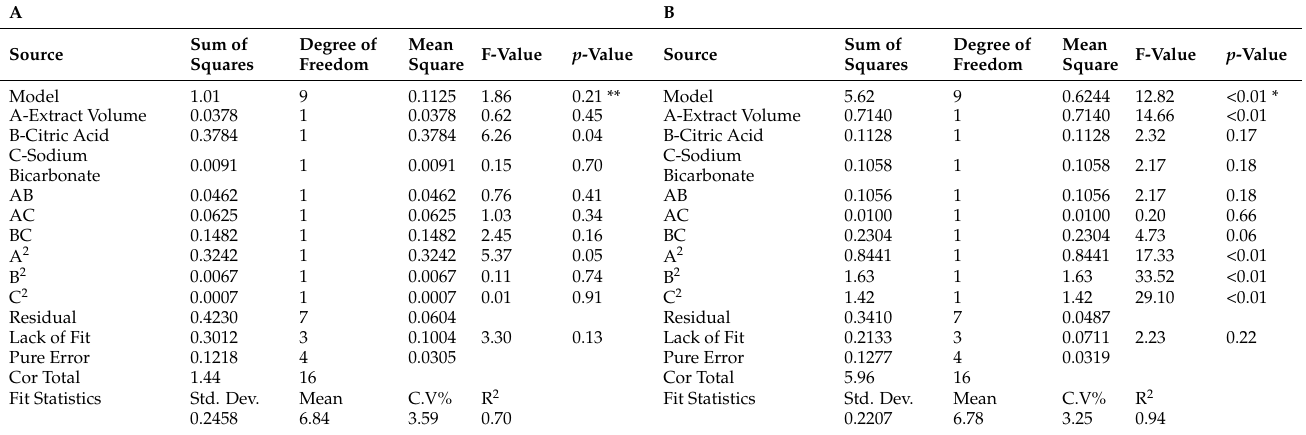
Table 2. Result of analysis of variance (ANOVA) texture response (A) and OAA response (B).